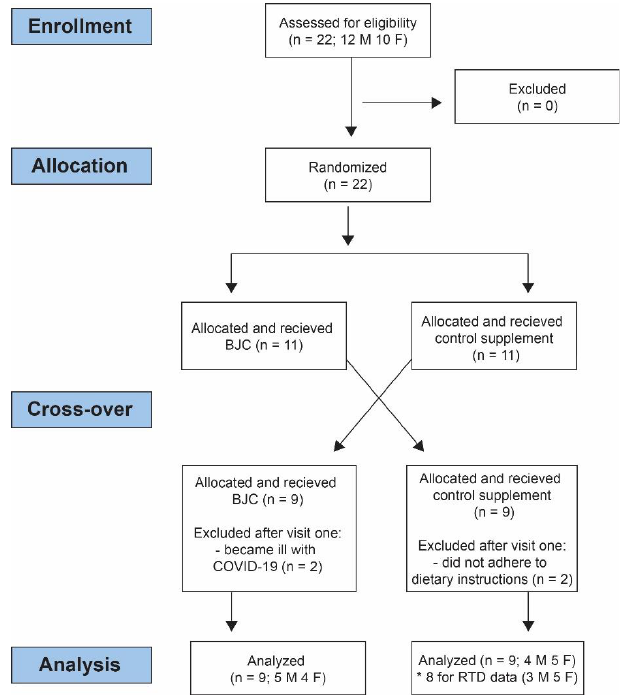
Figure 1. Study flowchart. * One participant excluded due to poor signal